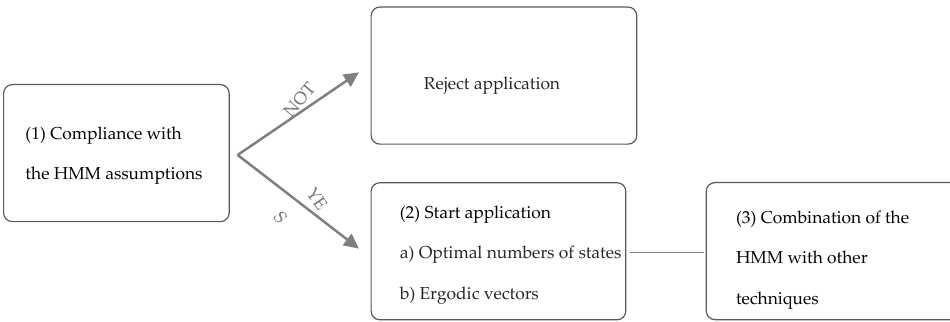
Figure 2. Methodological stages in the application of the HMM.